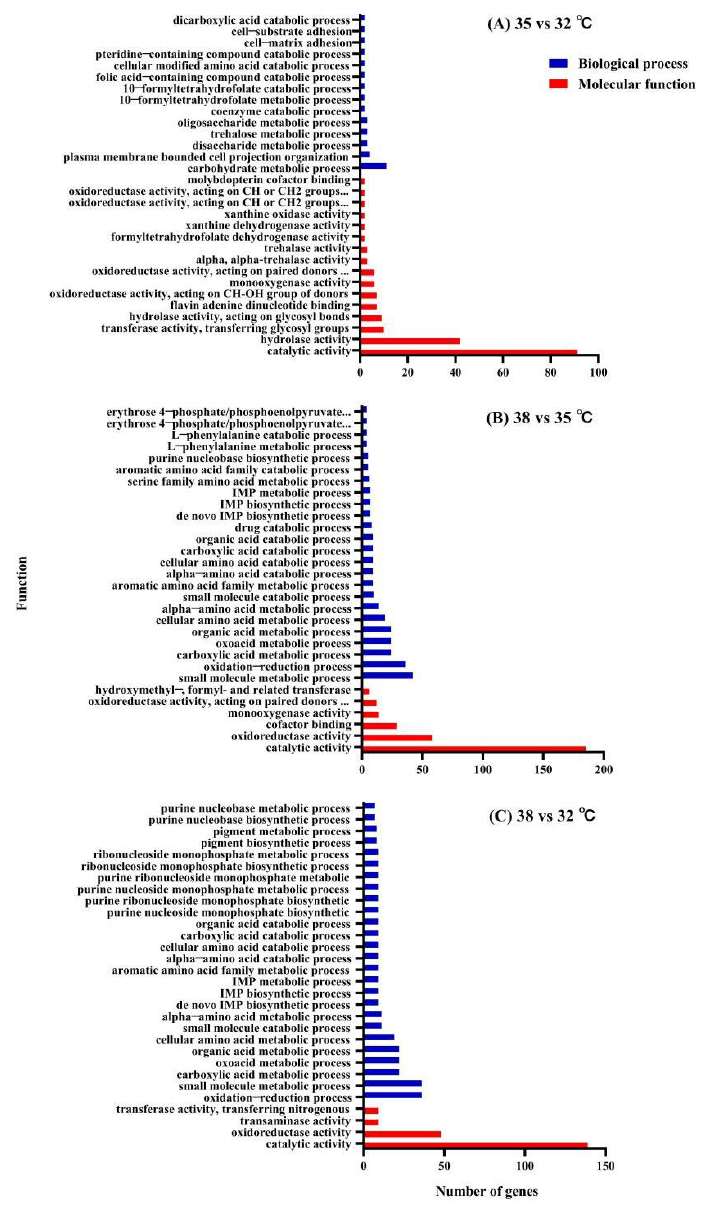
Figure 3. GO enrichment analysis of adult P. quatuordecimpunctata under different temperature stress.